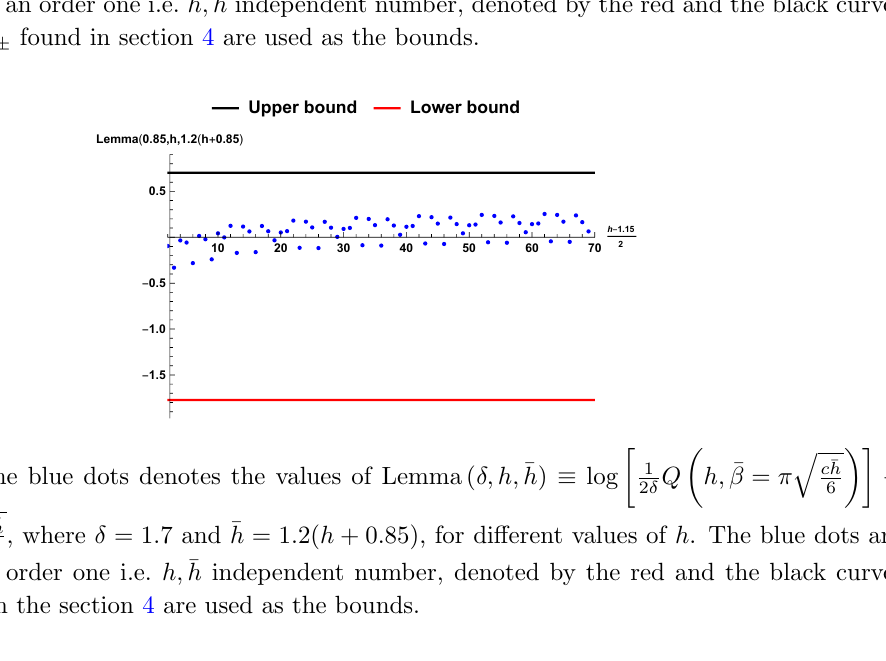
Figure 11 . The blue dots denotes the values of Lemma ( (cid:14); h; (cid:22) h ) (cid:17) log q q ch c (cid:22) h 2 (cid:25) (cid:0) (cid:25) , here we have (cid:14) = 1 : 45 and (cid:22) h = h + 1 : 65, for di(cid:11)erent values of h . The blue dots 6 6 are bounded by an order one i.e. h; (cid:22) h independent number, denoted by the red and the black curve. The values of c (cid:6) found in section 4 are used as the bounds.